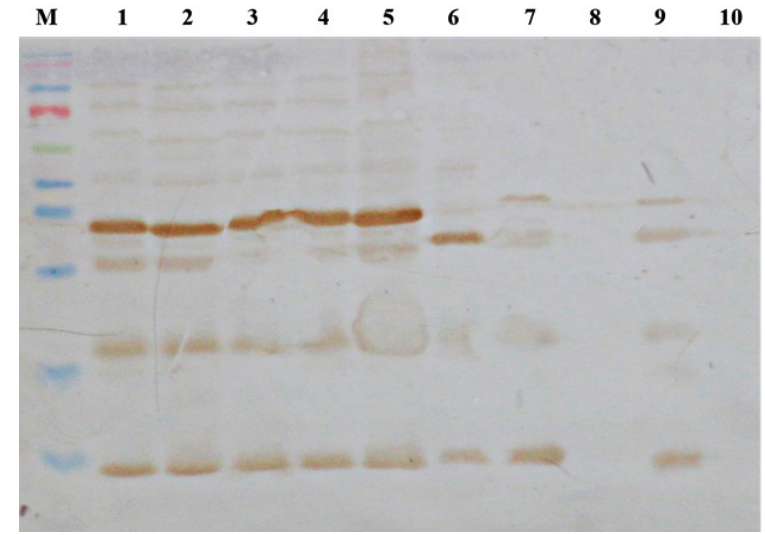
Fig. 1. Reactivity testing of anti-OMP-IgY by Western blot analysis. M — pre-stained protein ladder, L1-ETEC, L2— EHEC, L3—EPEC, L4—EAEC, L4—EPEC, L5— Salmonella typhimurium , L6 — Listeria monocytogenes ,